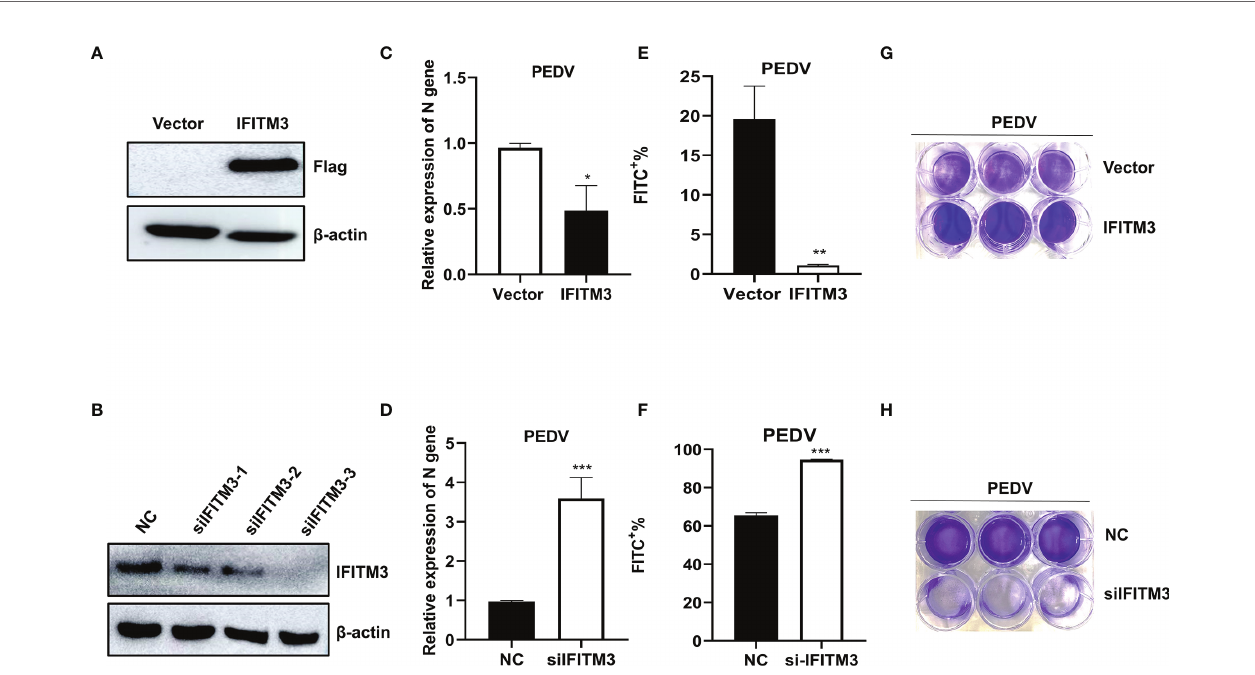
FIGURE 8 | Proliferation of PEDV in IFITM3-overexpressed and knocked-down Vero cells. Vero cells were transfected with pLV-sIFITM3-Flag or si-csa-IFITM3s for 48 h, followed by infection with PEDV (MOI = 1) for 48 h. The proliferation of PEDV in IFITM3-overexpressed and knocked-down Vero cells was evaluated at 24 h